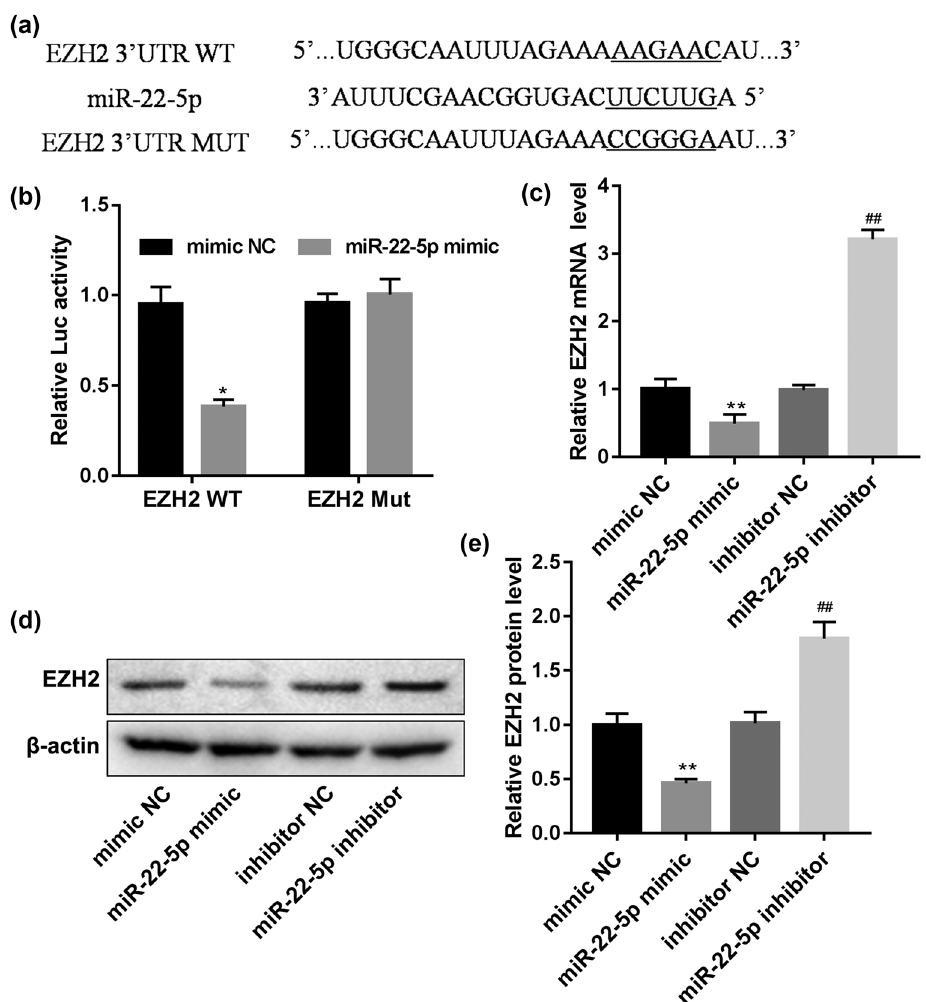
Figure 3: miR - 22 - 5p directly targets EZH2. ( a ) The target region of the EZH2 3 ′ UTR for miR - 22 - 5p and the mutant type of EZH2 3 ′ UTR. ( b ) E ff ects of miR - 22 - 5p on the activity of fi re fl y luciferase reporters containing either wild - type ( Wt ) or mutant - type ( Mut ) 3 ′ UTR were assessed by luciferase reporter gene assays. ( c – e ) E ff ects of miR - 22 - 5p on EZH2 expression levels were examined by qRT - PCR and western blot analyses. * p < 0.05, ** p < 0.01 vs mimic NC; ## p < 0.01 vs inhibitor